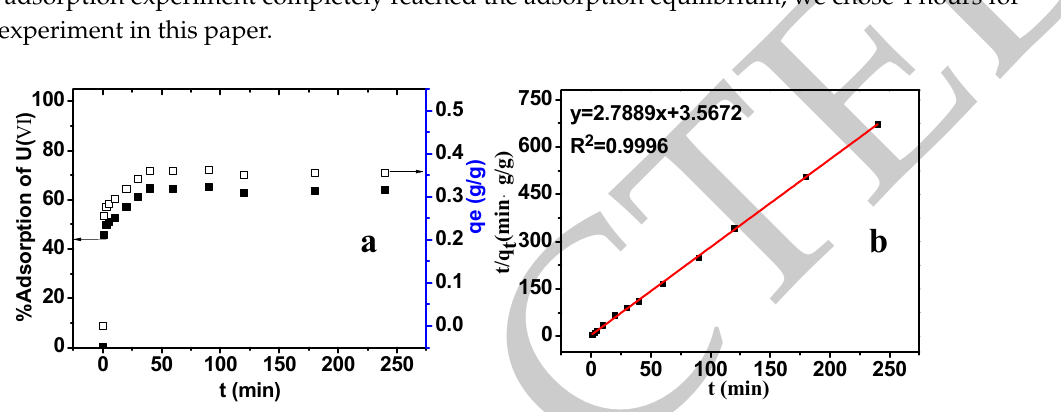
Figure 10. Effect of the contact time on the adsorption of U (VI) onto β -CD- g -(MAH- co -AO) ( a ) and the pseudo-second-order adsorption kinetics plot for U (VI) ( b ). ([U(VI)] 0 = 4.1240 × 10 − 4 M, pH = 4.00 ± 0.05, T = 298.15 ± 1.00 K, I = 0.50 M NaNO 3 , m / V = 0.20 g/L).